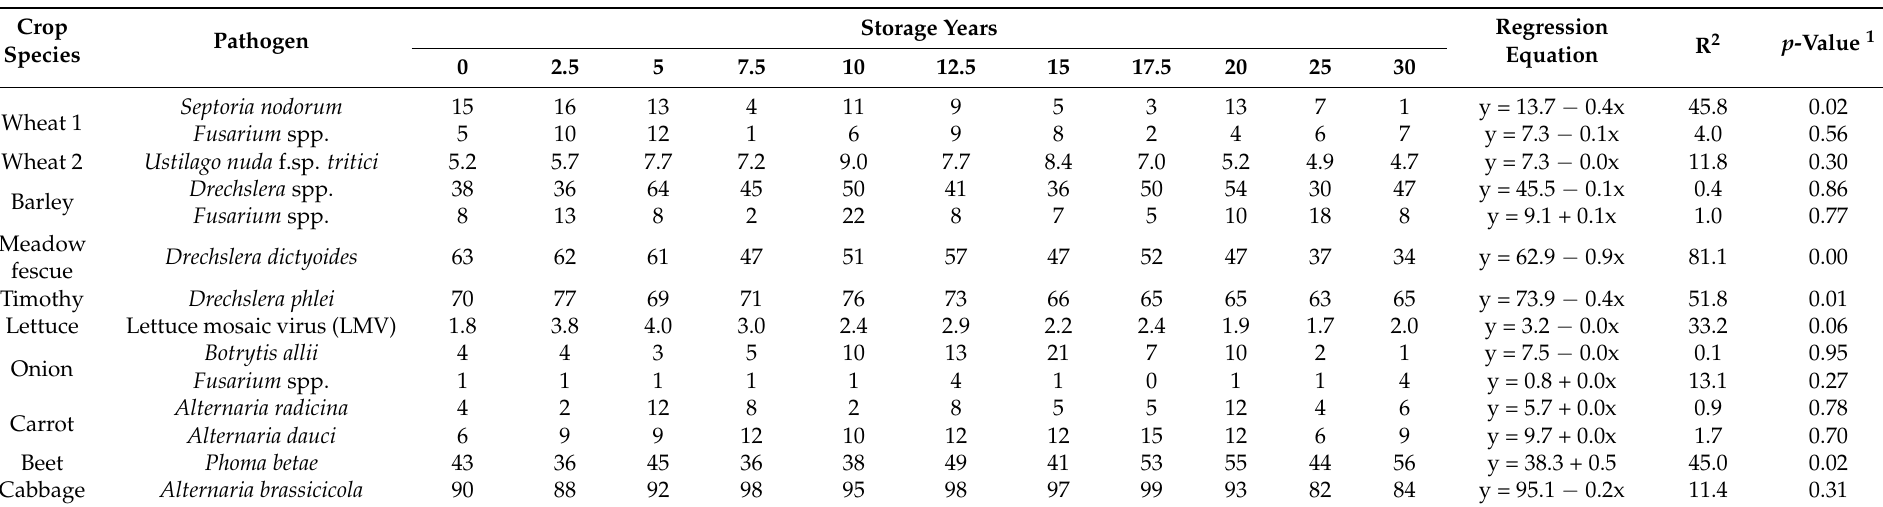
Table 2. Percentages of infected seeds and simple linear regression analyses of pathogen infection during the first 30 years of the 100-year storage experiment with 10 seed lots stored at − 3.5 ◦ C (permafrost) in an abandoned coalmine in Svalbard,